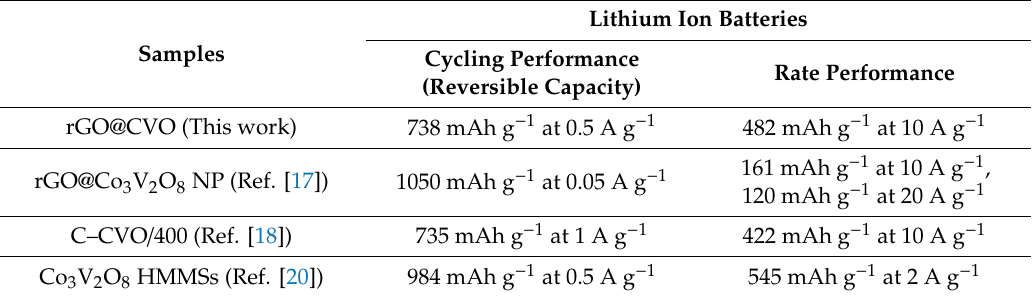
Figure 4. ( a ) Cycling performance of rGO@CVO and CVO at 0.5 A g − 1 ; ( b ) long-term cycling performance of rGO@CVO electrode at 2 A g − 1 ; ( c ) rate capability of rGO@CVO and CVO electrodes. Table 1. A comparison of the electrochemical performances of rGO@CVO (this work) and other attempts in lithium ion batteries.